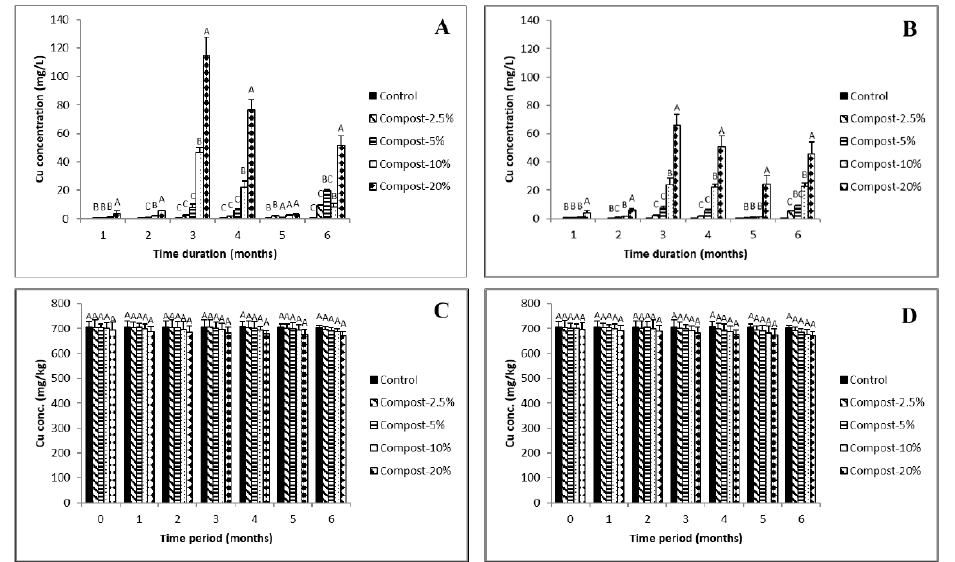
Figure 2. Top panel: Total Cu (mg/L) in leachates of camelina ( A ) and field pennycress ( B ) and soil as affected by different rates of compost during the study period. Bottom panel: Total Cu (mg/kg) in soil in camelina ( C ) and field pennycress ( D ) during the study period. Data are reported as mean ± S.D ( n = 3). Means are compared by Tukey Kramer-HSD test ( α = 0.05). The treatment levels that are not connected by the same letter are significantly different from each other.